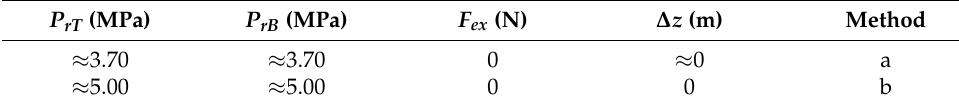
Table 3. Simulation results under non-loading conditions.